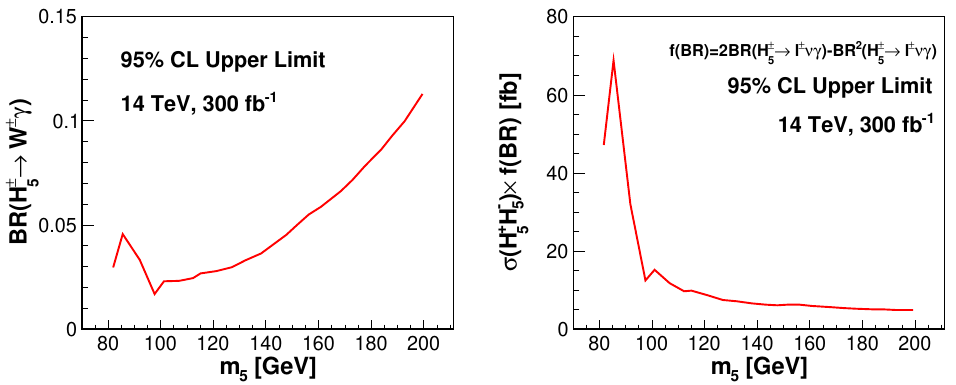
Figure 8 . Left: the projected 95% CL upper limit on BR( H (cid:6) the W(cid:13) search. Right: the projected 95% CL upper limit on (cid:27) ( pp ‘ (cid:6) (cid:23)(cid:13) ) ‘ (cid:6) (cid:23)(cid:13) )), assuming that pp BR 2 ( H (cid:6) 5 ! (cid:0) assume 300 fb (cid:0) 1 of data at the 14 TeV